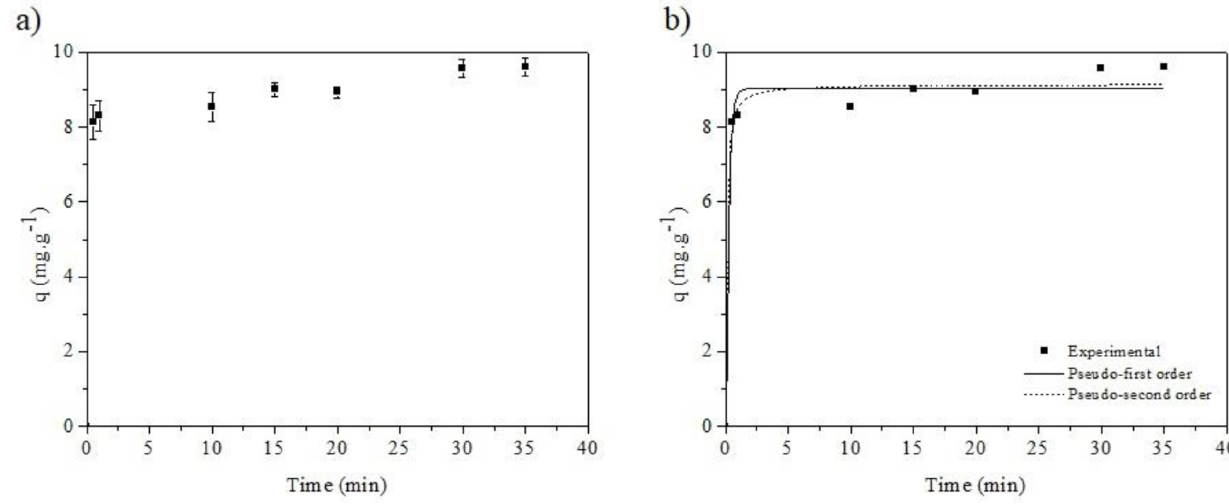
Figure 10. Pseudo-first-order kinetic model and pseudo-second-order kinetic model. Table 2. Parameters of the kinetic models fitted to the experimental